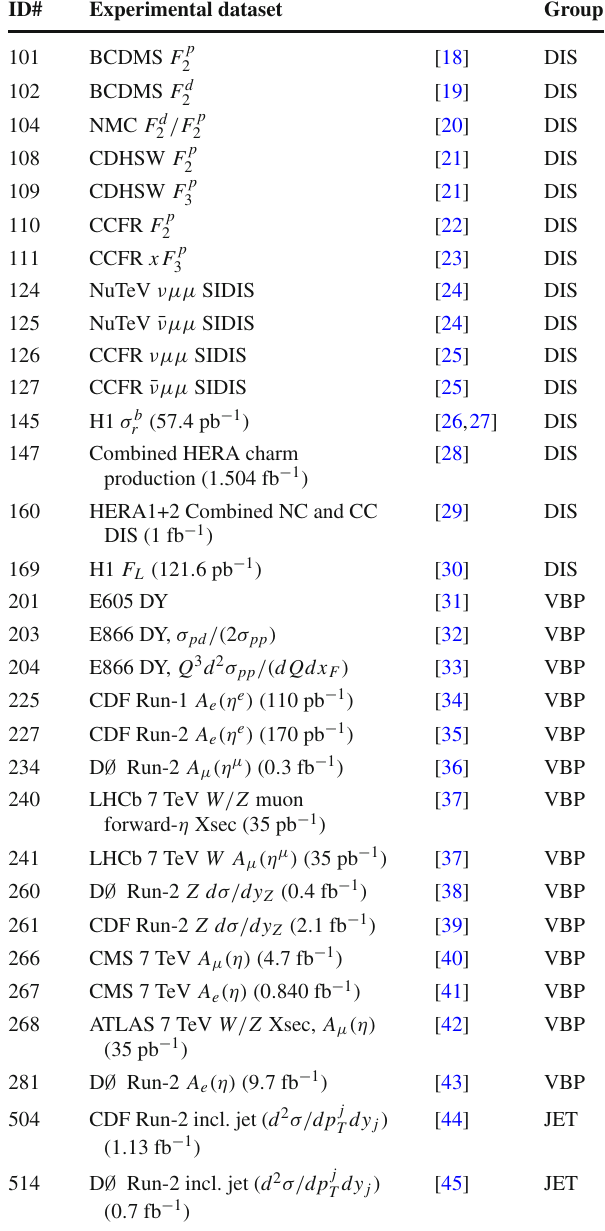
Table 3 Experimental datasets considered as part of CT14HERA2 and included in the analysis. IDs are following the standard CTEQ